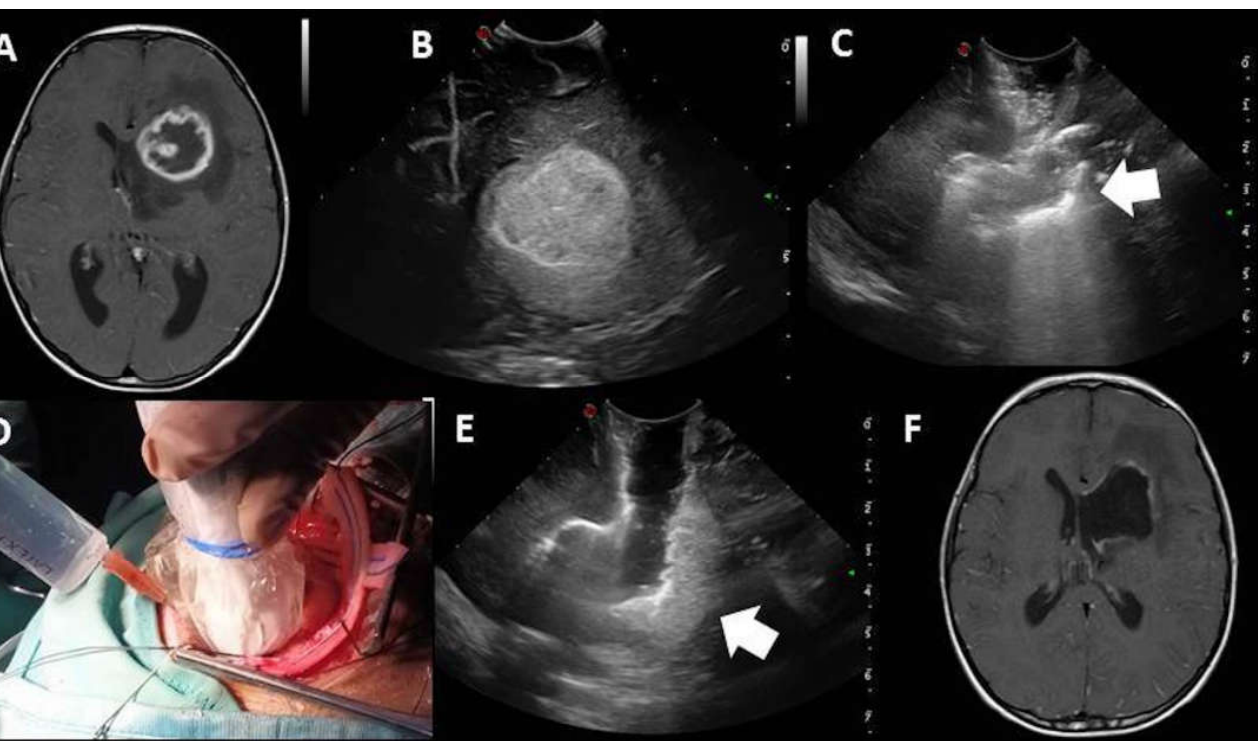
Figure 4. MR showing large frontal periventricular high-grade glioma ( A ). Pre-IOUS confirming large hyperechoic nodular lesion, consistent with preoperative MR picture ( B ). Post-IOUS is limited by artifacts (arrow) and partially collapsed surgical cavity ( C ). The d-IOUS ( D ) ensures distension of the surgical cavity with reduction of the artifacts, thus confirming the presence of residual tumor (arrow, E ) that was then surgically resected. Radical resection was confirmed by postoperative MR ( F ). Overall, a total concordance of post-IOUS to postoperative MRI was noted. Indeed, the EOR assessed by MR was consistent with the initial surgical plan and EOR assessed by IOUS. In particular, gross total resection was obtained in 40 cases (89%) and subtotal resection in the remaining five cases due to residual tumor in eloquent region, as highlighted by intraoperative neurophysiological